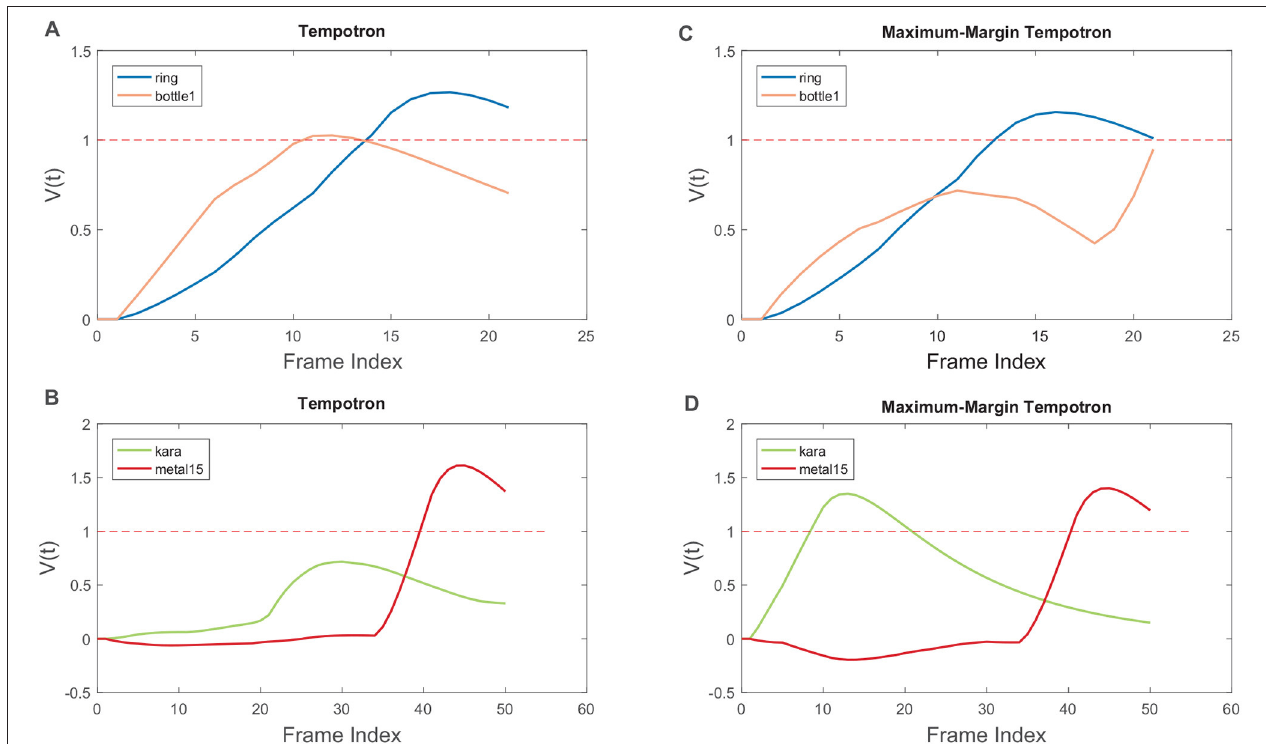
FIGURE 7 | Selected samples misclassified by the Tempotron learning rule, while classified correctly by the modified Maximum-Margin Tempotron learning rule. Sample from the “ring” class misclassified as “bottle1” (A) , while correctly classified with Maximum-Margin Tempotron learning rule (C) . Sample from the “kara” class misclassified as “metal15” (B) , while correctly classified with Maximum-Margin Tempotron learning rule (D)